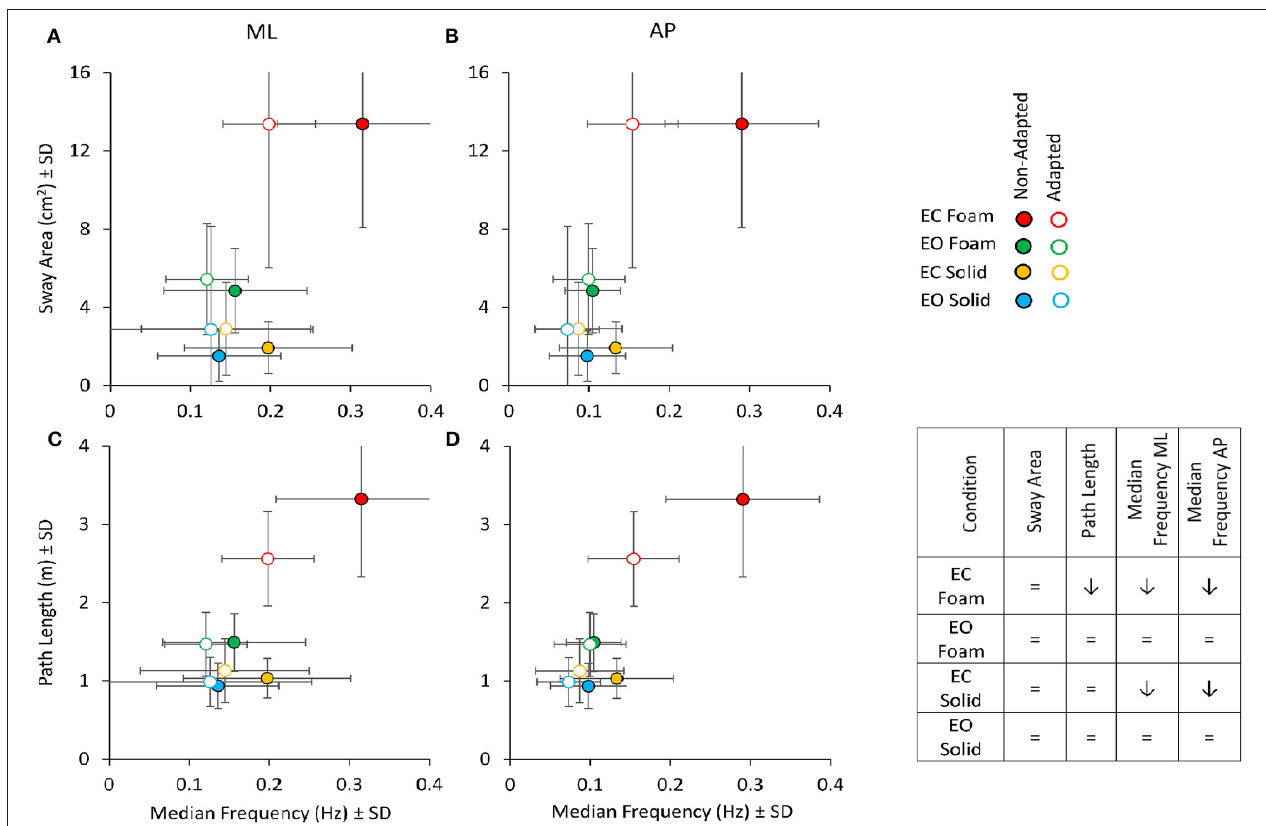
FIGURE 9 | Sway Area (top panels) and Path Length (bottom panels) vs. Median Frequency for non-adapted (filled symbols) and adapted trials (empty symbols). For each visual condition and support surface, the mean value of Sway Area or Path Length is plotted against the corresponding mean value of the Median Frequency for both ML (A,C) and AP (B,D) directions. Note that the values of Sway Area and Path Length are the same for the left and right panels. Filled symbols refer to the non-adapted, open symbols to the adapted trial. With adaptation, both Path Length and Median Frequency decrease, especially in the EC Foam condition. Sway Area, except for the EC Foam, tended to increase with adaptation, even if not significantly. The Table inset summarises the effect of adaptation on the considered variables ( = indicates no significant effect of adaptation; ↓ points to a significant diminution in the value of the